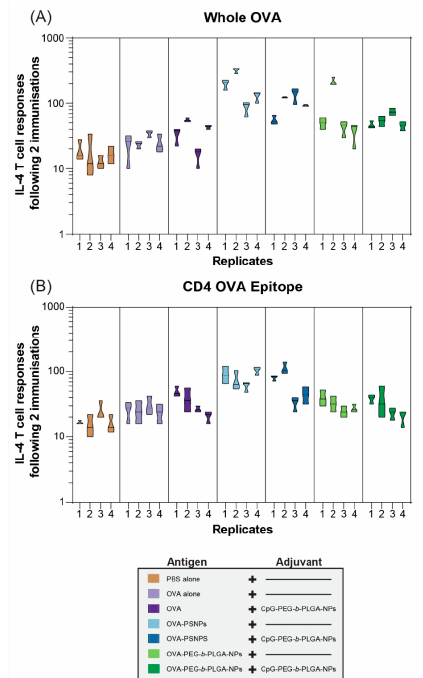
Figure 3. Interleukin 4 (IL-4) T-cell responses to nanovaccine formulations at day 28. C57BL/6 mice were immunized twice, two weeks apart, intradermally at the base of the tail with the following formulations; phosphate buffered saline (PBS) alone (Naïve), OVA alone, OVA + CpG-PEG- b -PLGA NPs, OVA-PS NPs, OVA-PS NPs + CpG-PEG- b -PLGA NPs, OVA-PEG- b -PLGA NPs, or OVA-PEG- b - PLGA NPs + CpG-PEG- b -PLGA NPs. All animals received 50 µg OVA. CpG-PEG- b -PLGA groups received 5 µg CpG. Graph shows IL-4 T-cell responses to ( A ) whole OVA and the ( B ) CD4+ T-helper OVA epitope by ELISpot assay. Individual mice (replicates 1–4 for control and treatment groups) are shown for each recall antigen ± experimental error from triplicate assay wells.